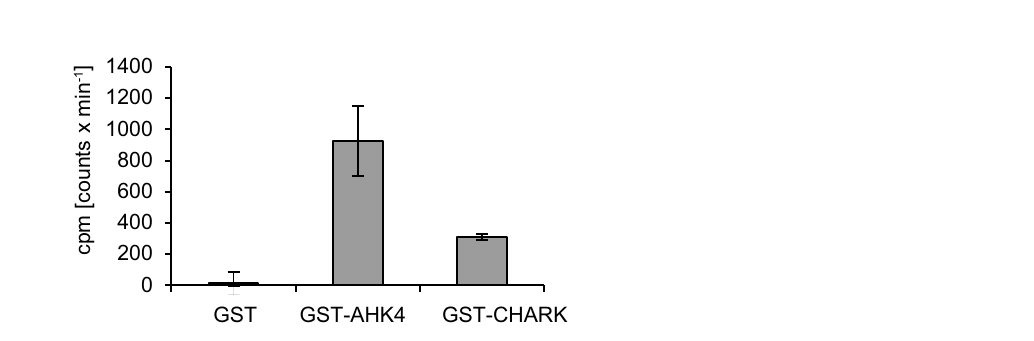
Figure 3. Specific cytokinin binding activity of CHARK in an in vivo binding assay. AHK4 and CHARK were expressed as GST fusion proteins in E. coli strain KMI002 and bacterial cells were assayed for specific trans -[ 3 H] zeatin binding 27 . The empty pDEST15 vector was used as a negative control. The assay was performed with three independent bacterial colonies for each construct and the binding activity was measured twice for each colony. Error bars indicate the standard deviation ( n = 3). The protein expression was confirmed by western blot analysis with GST antibody (Supplemental Fig.